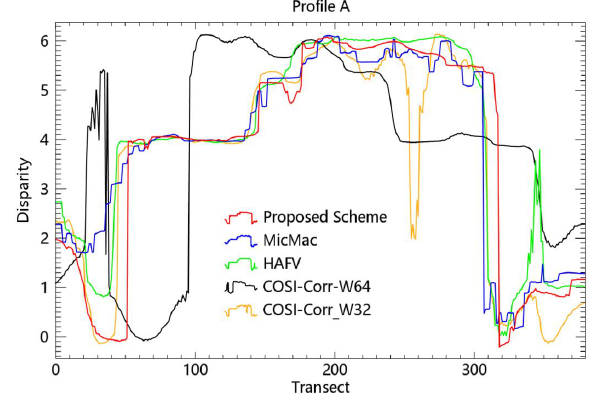
Figure 9. Comparison of the disparity along a random profile (see Fig.